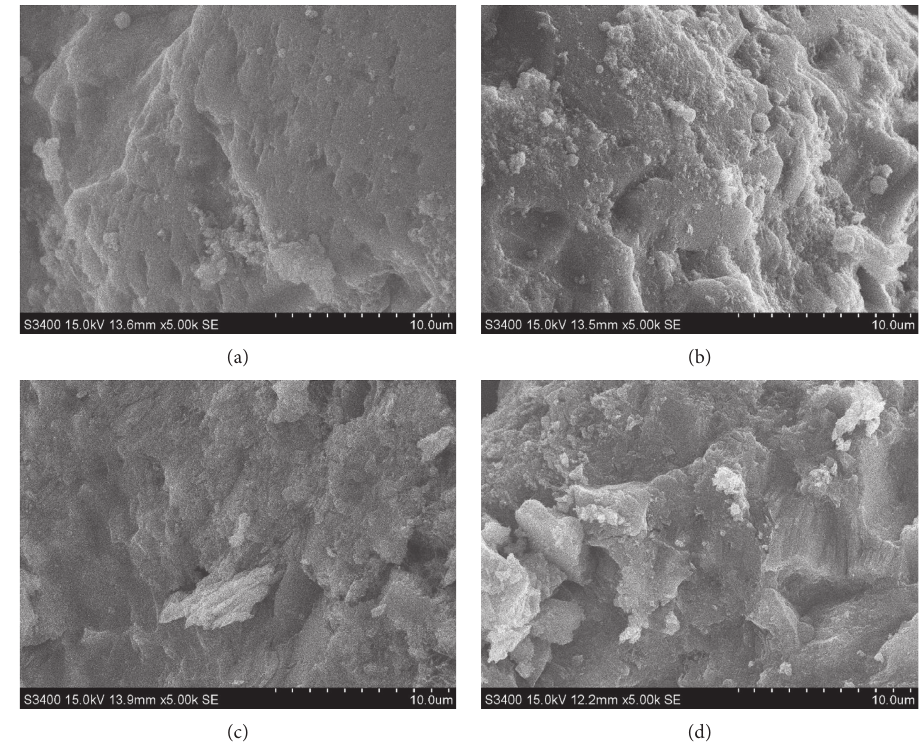
Figure 7: Mesomorphology of GTCM for 3 days: (a) GTCM-0 under the SC method; (b) GTCM-20 under the SC method; (c) GTCM-0 under the HWC method; (d) GTCM-20 under the HWC method.